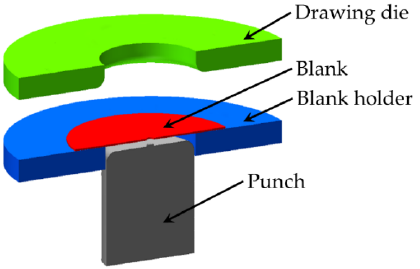
Figure 3. Cross-section of the CAD model for Finite Element (FE) simulation.